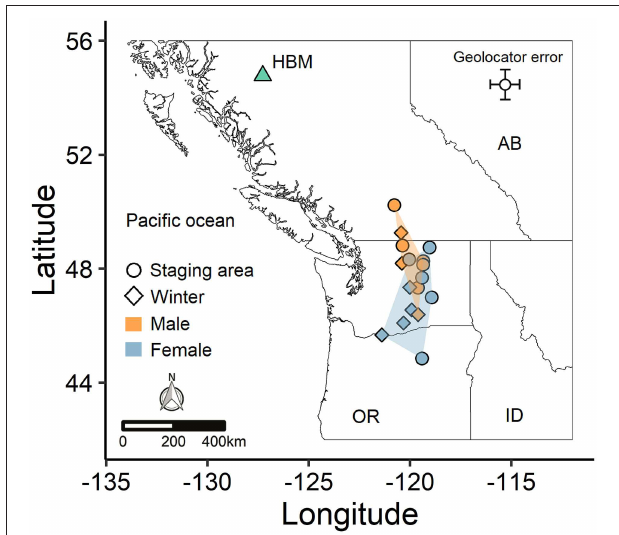
FIGURE 2 | Spatial segregation of male and female non-breeding areas for an alpine population of horned lark. Points indicate the last prolonged stationary period for each individual prior to migrating back to the breeding site (HBM), based on whether the individual used a staging area (circle) or traveled straight from the winter site (diamond). Shaded regions depict the minimum convex polygons for each sex.